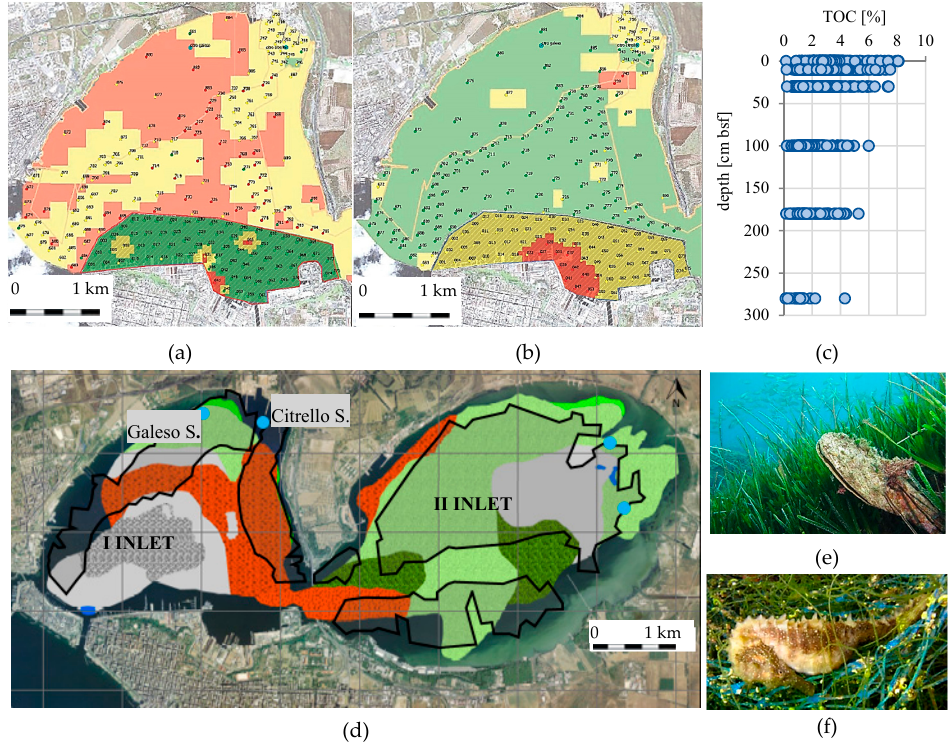
Figure 3. Environmental features of the Mar Piccolo [22,28,29]. Statistical representation of pollution level by Hg ( a ) and polychlorinated biphenyls (PCBs) ( b ) in the first 50 cm below seafloor of the First Inlet, key: green, acceptable level (concentration below site-specific limit [33], Table 1); yellow, medium level (concentration above site-specific limit [33], Table 1); red, heavy level of pollution (concentration above law limit [34], Table 1). ( c ) Profiles of total organic carbon up to 3 m below the seafloor (bsf). ( d ) Map of biocenosis, key: ■ seabed without algae; ■ seabed covered by macroalgae; ■■ seabed covered by several species of algae; ■ seabed covered by debris of shell fragments; black contours define the mussel cultivation areas; ● main submarine freshwater springs (Citri).